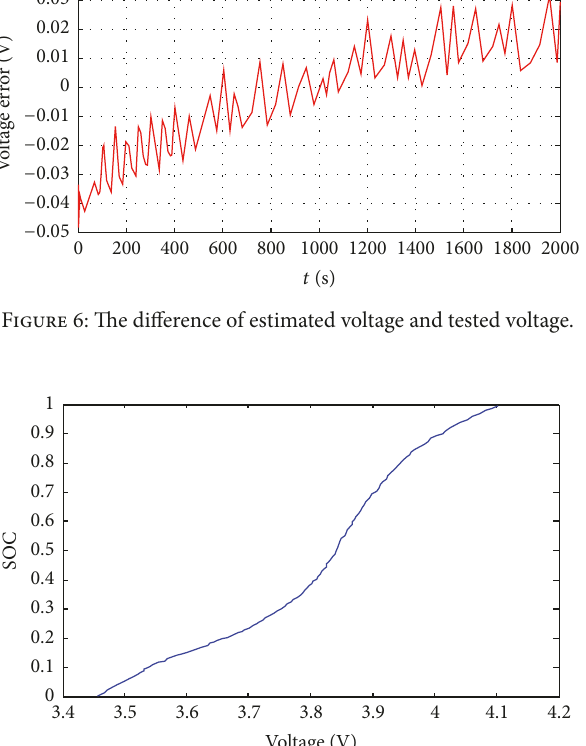
Table 2: Parameters of second-order RC battery model obtained by experimental data.